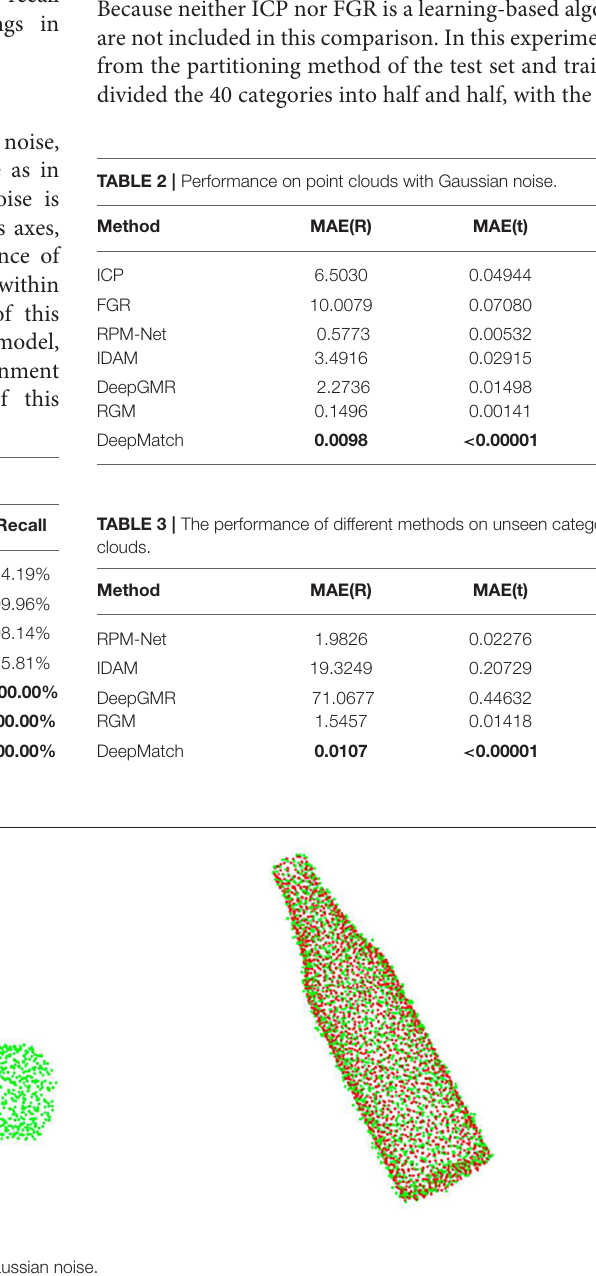
FIGURE 3 | DeepMatch completes the registration under inputs with Gaussian noise.